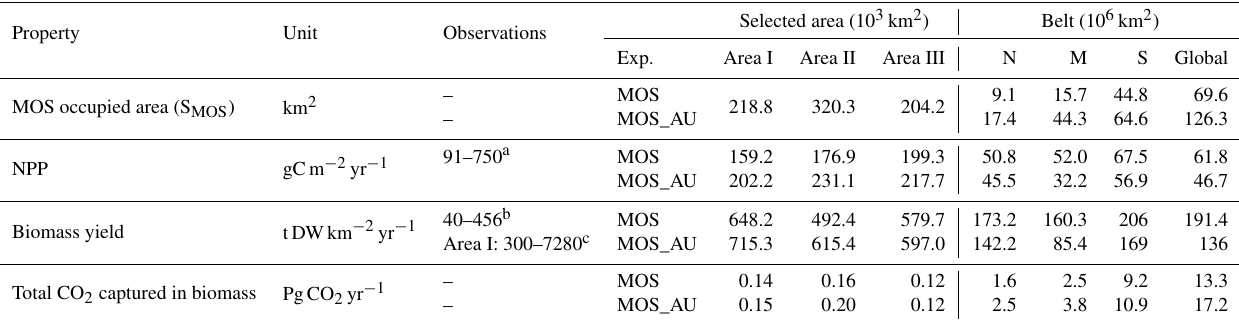
Table 4. Properties of globally implemented MOS. Selected areas are from data of year 2024, whereas belt areas are values averaged from 2020 to 2024. Areal NPP rates and “Biomass yield” refer to the respective MOS area. The observational data come from the references. Property Unit Observations